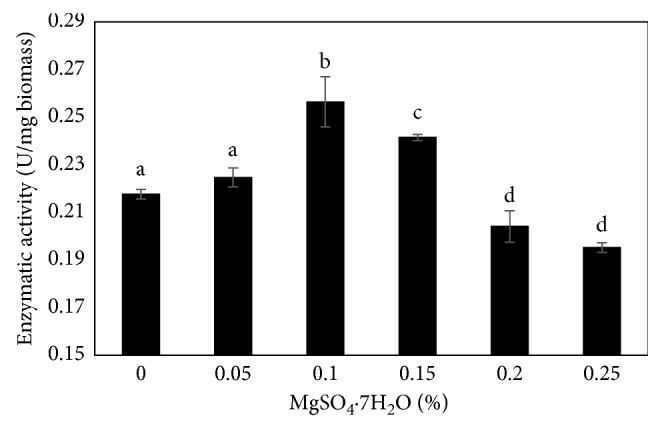
The effect of the concentration of MgSO4·7H2O on glucose isomerase production. The concentration of MgSO4·7H2O was increased (0-0.1%) along with enhancement of enzyme activity. We observed that the higher concentration of MgSO4·7H2O (0.15–0.25%) resulted in a decline of enzyme activity. We chose 0.1% of MgSO4·7H2O to further optimization experiments. a, b, c, and d indicate the significant difference between groups.